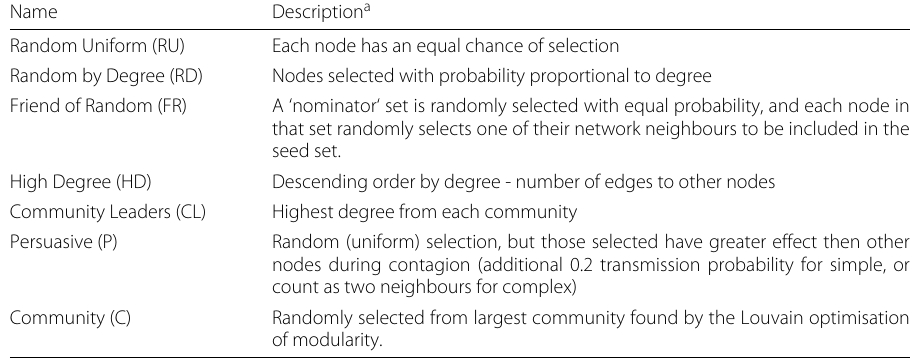
Table 3 Network interventions